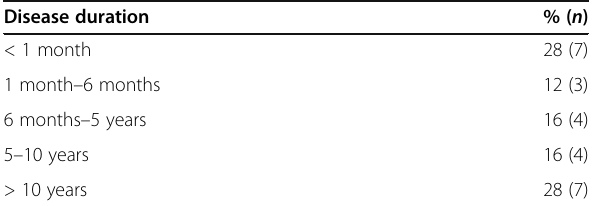
Table 3 Disease